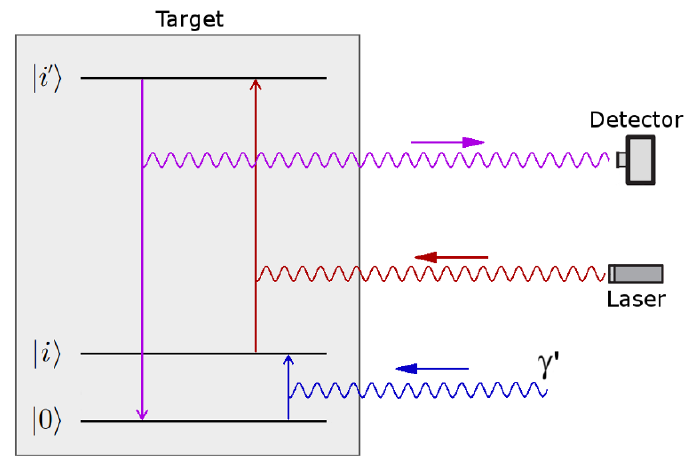
Figure 2 . Scheme of the experimental setup for detecting